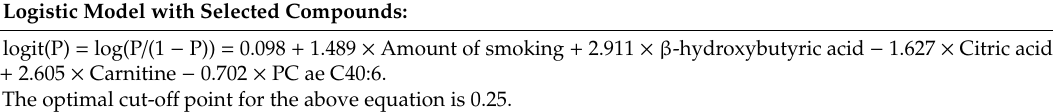
Table 5. Logistic regression based optimal model for stage II NSCLC detection: metabolites plus smoking